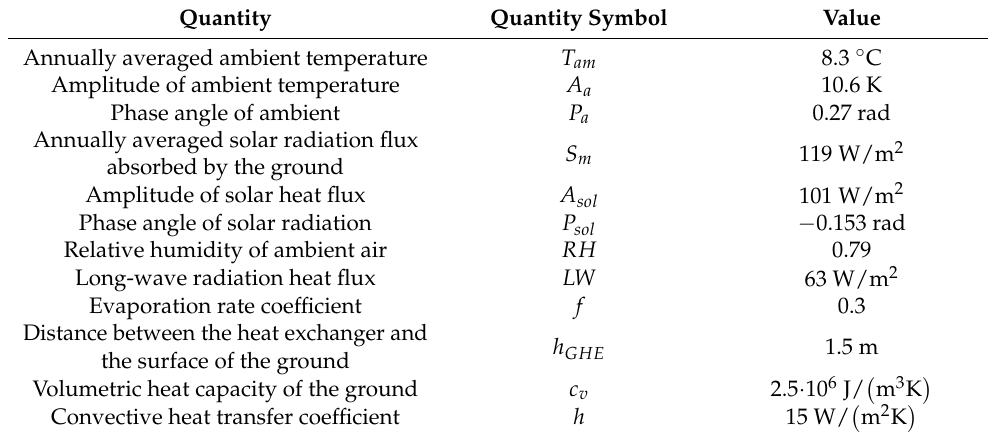
Table 1. Summary of the values of quantities present in the model and used in simulation calculations.